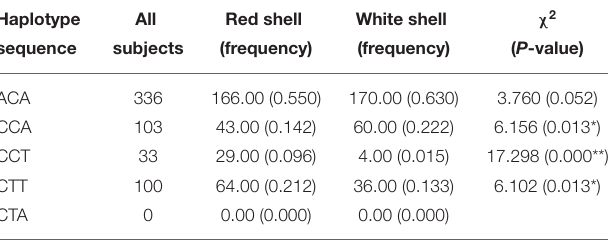
TABLE 6 | Haplotype analysis of three SNPs of Mm-BCDO2 gene.